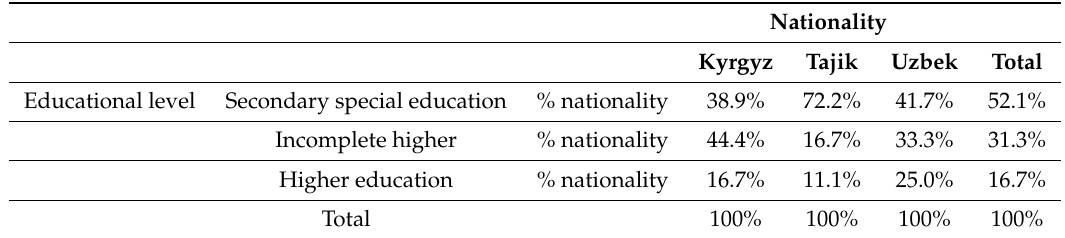
Table 2. The level of